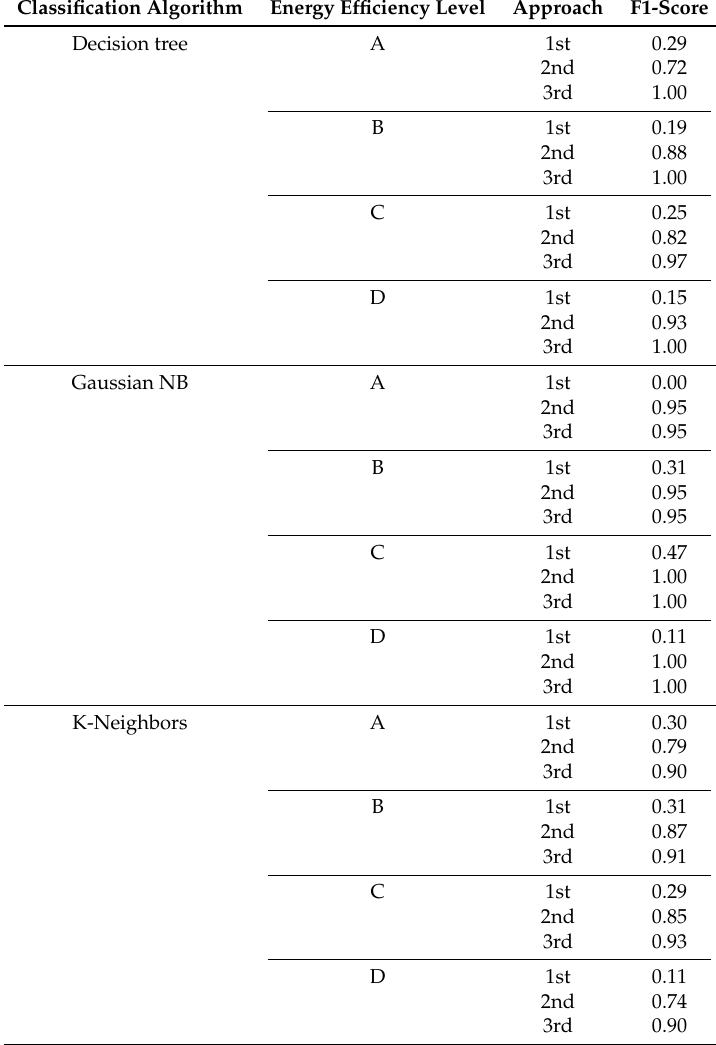
Table 8. F1-scores comparison for the best